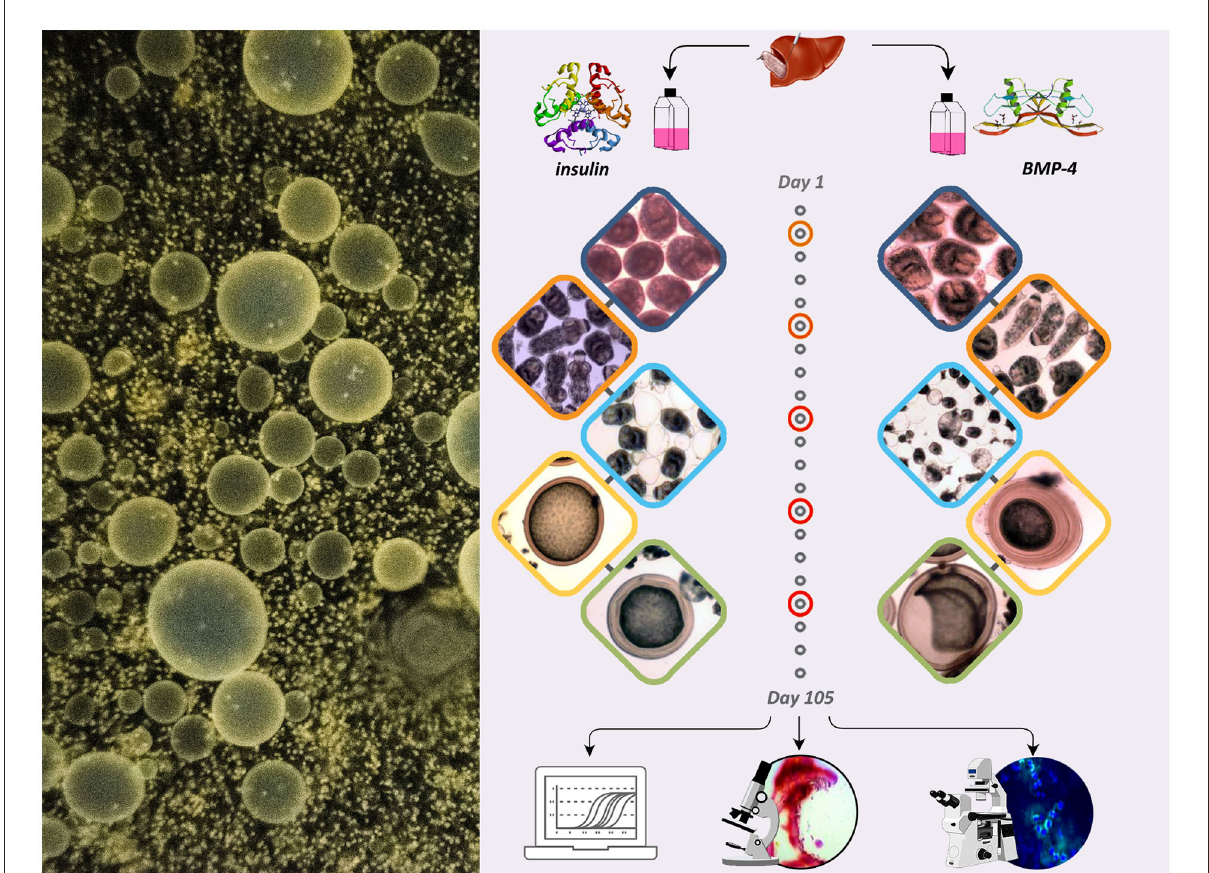
FIGURE1 The schematic presentation of the study showing the effect of insulin and BMP-4 on the growth and development of E. granulosus cultured in vitro for 105